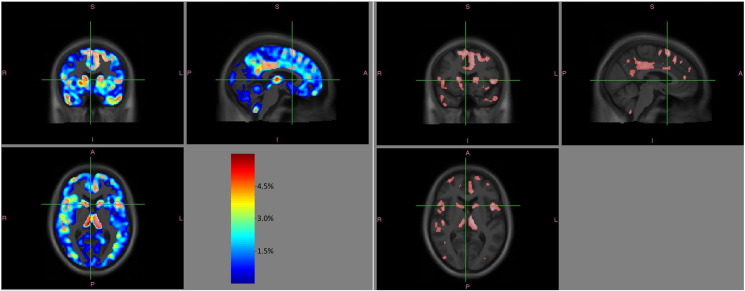
Yearly rate of additional GM fractional volume reduction for patients beyond that seen in controls (left). The colorbar is set to 0–6%. The right-hand-side panel shows for comparison on the same sections the areas of significant differences in yearly rates of GM volume reductions in patients vs controls as shown in Fig. 2A (FDR p < 0.05).